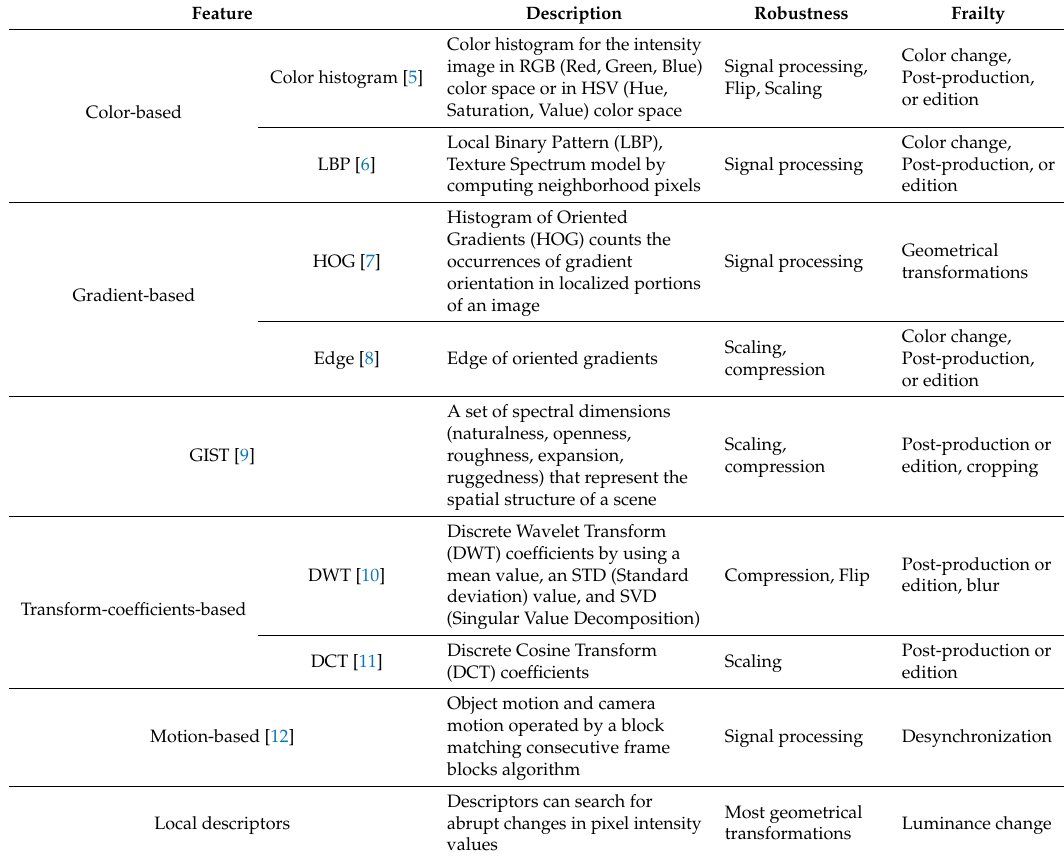
Table 1. Examples of common features for image/video processing and their robustness and frailty to image/video